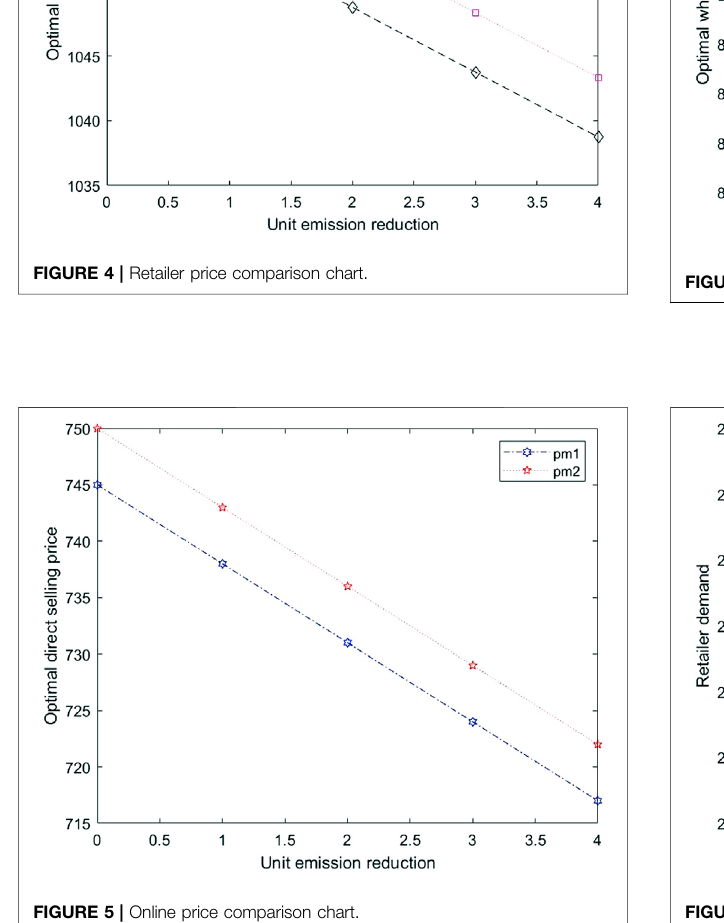
FIGURE 7 | Retailer demand comparison